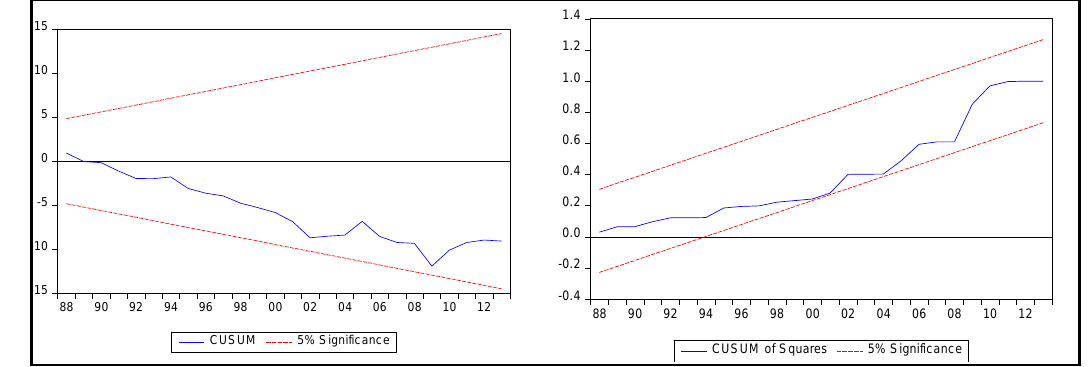
Figure 3. Graphs of the stability test on the residual of Equation (4).